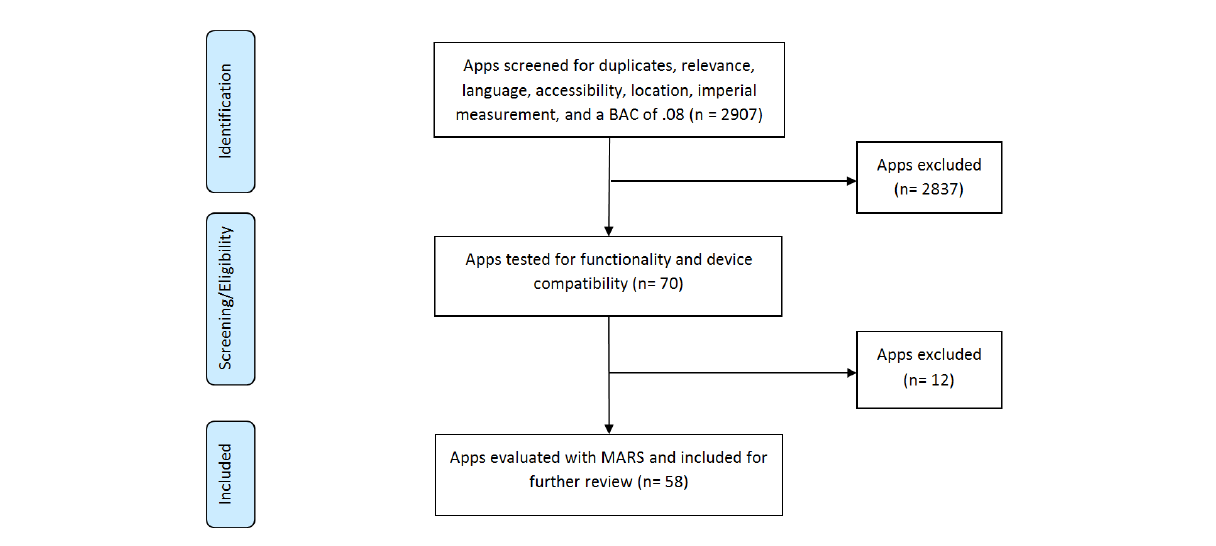
Figure 1. Systematic search of drink driving prevention apps selected for MARS